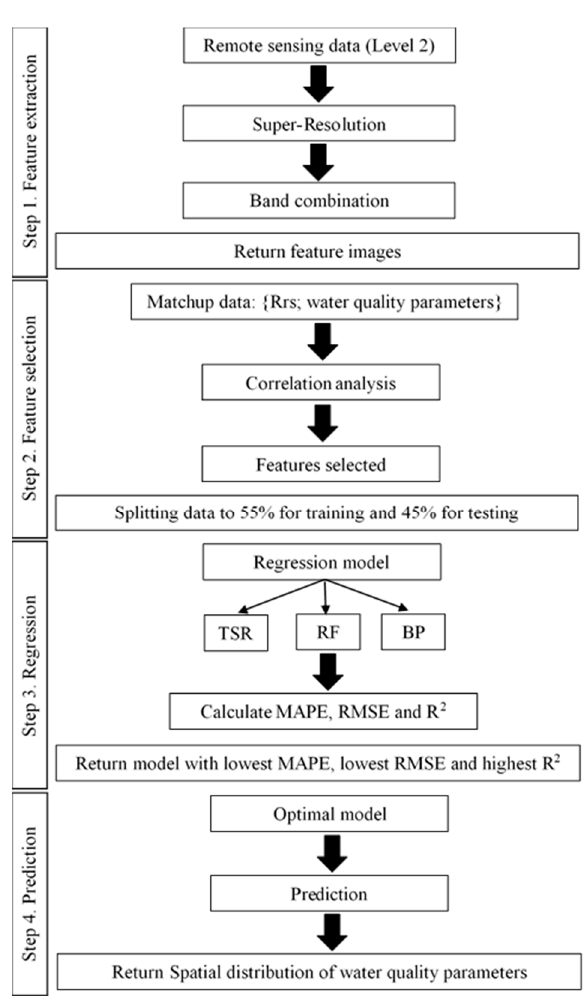
Figure 2. Estimation of water quality parameters of inland medium and small rivers based on the super-resolution algorithm.